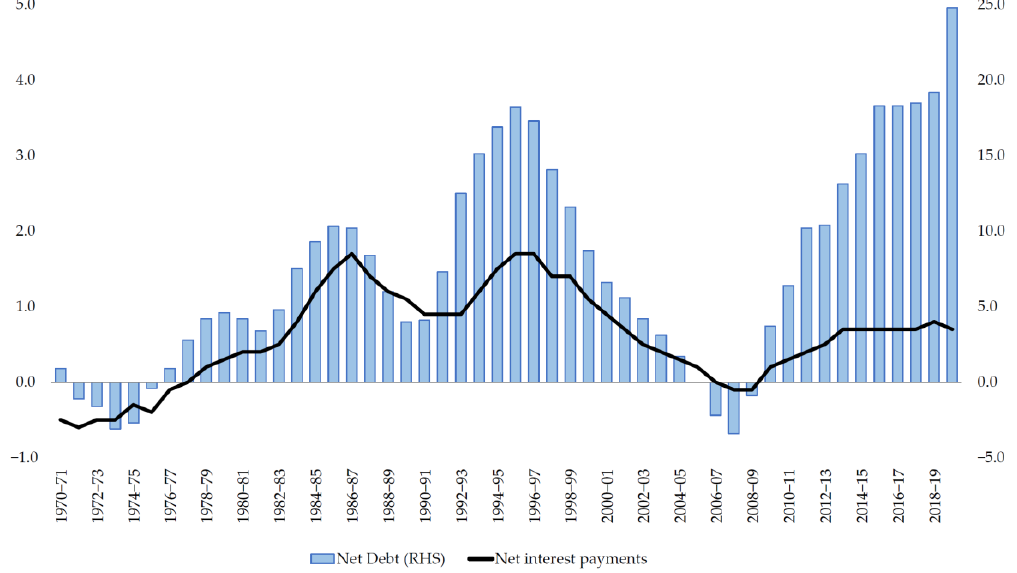
Figure 2. Australian Government general government sector net debt and net interest payments (percent of GDP). Notes: (a) Net debt is the sum of interest bearing liabilities less the sum of selected financial assets (cash and deposits, advances paid, and investments, loans, and placements). (b) Net interest payments are equal to the difference between interest paid and interest receipts. Source: Australian Government, budget strategy and outlook: budget paper no. 1: 2020 − 2021, statement